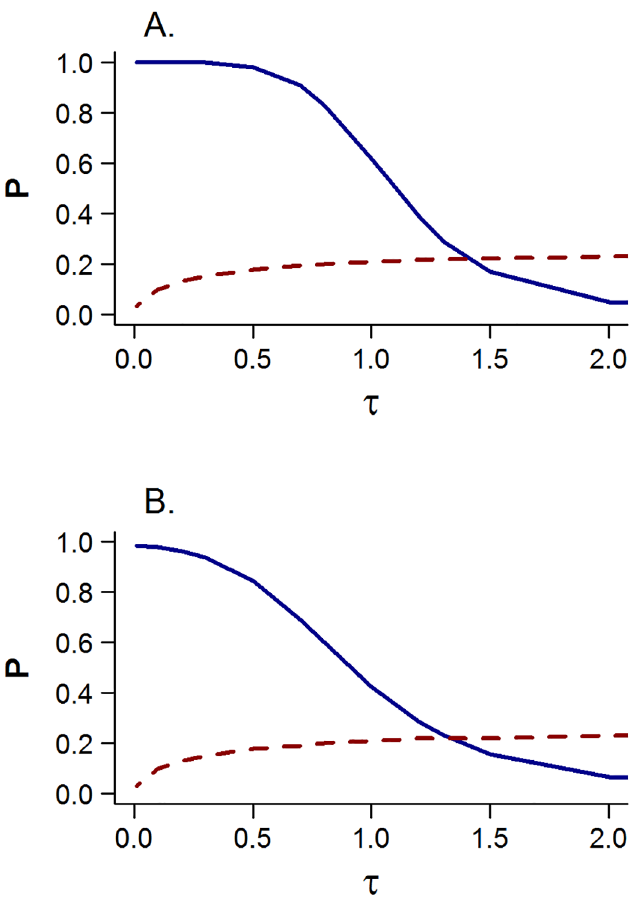
Fig 2. Relative AICc statistical weights P assigned to the regime shift hypothesis (solid line) and the estimated standard deviation of the observation error (dashed line). The upper plot (A) represents the three-line regime shift model and the lower plot (B) represents the bi-phasic Beverton-Holt (regime shift) model. Note that the weights in this case are computed for the two separate pairs of models, i.e., eq 13 is applied to (A) the single Beverton-Holt and three-line models and (B) the single and bi-phasic Beverton-Holt